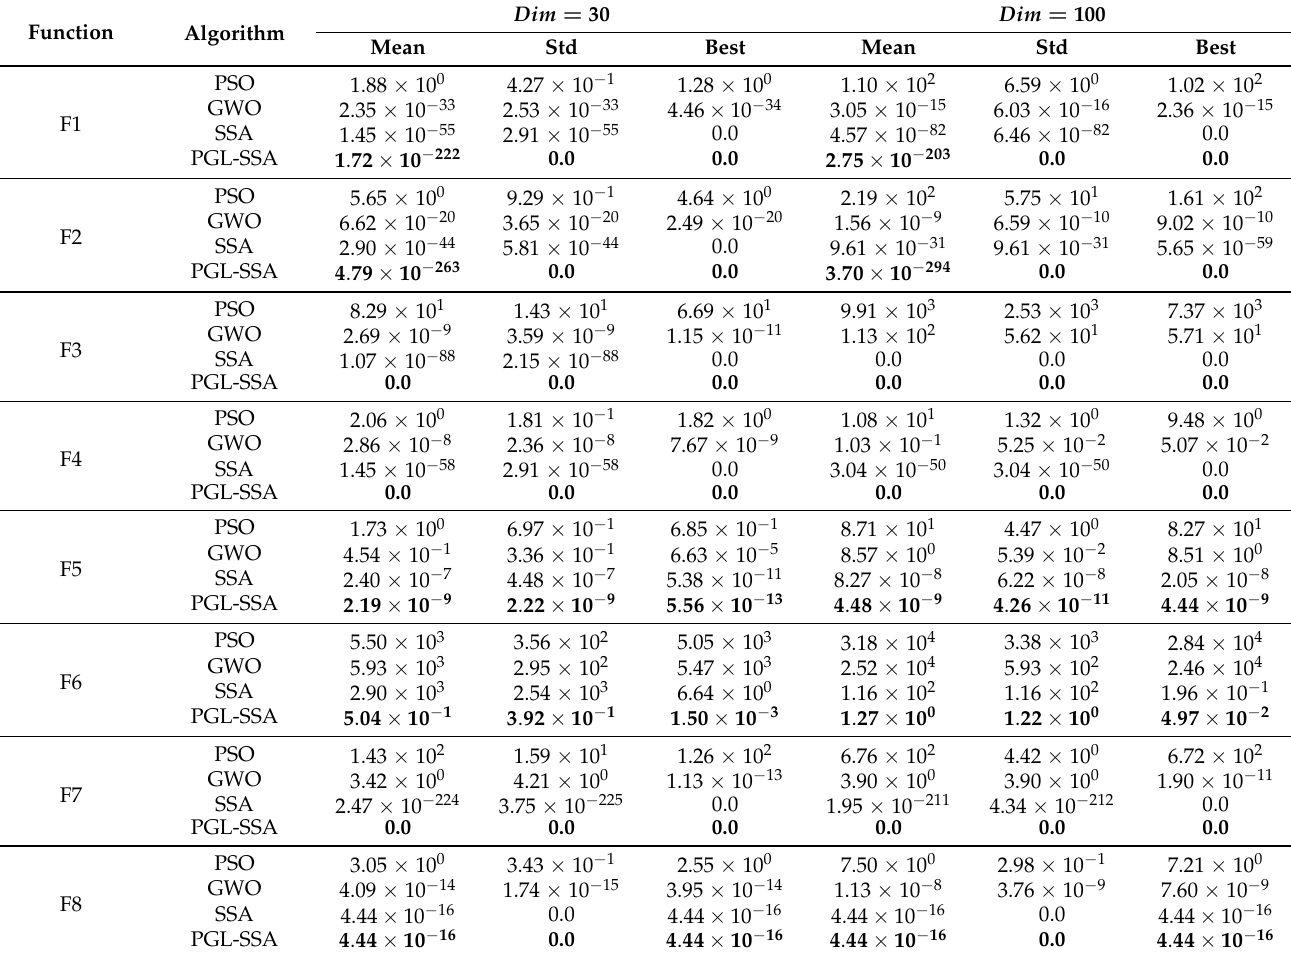
Table 3. Results and comparison of different algorithms for 21 benchmark